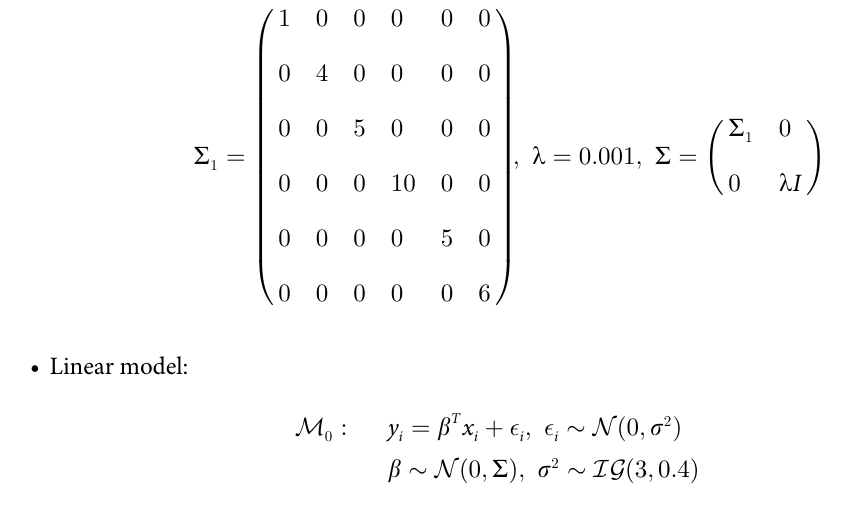
, the lines b T x þ h T z are 3 j